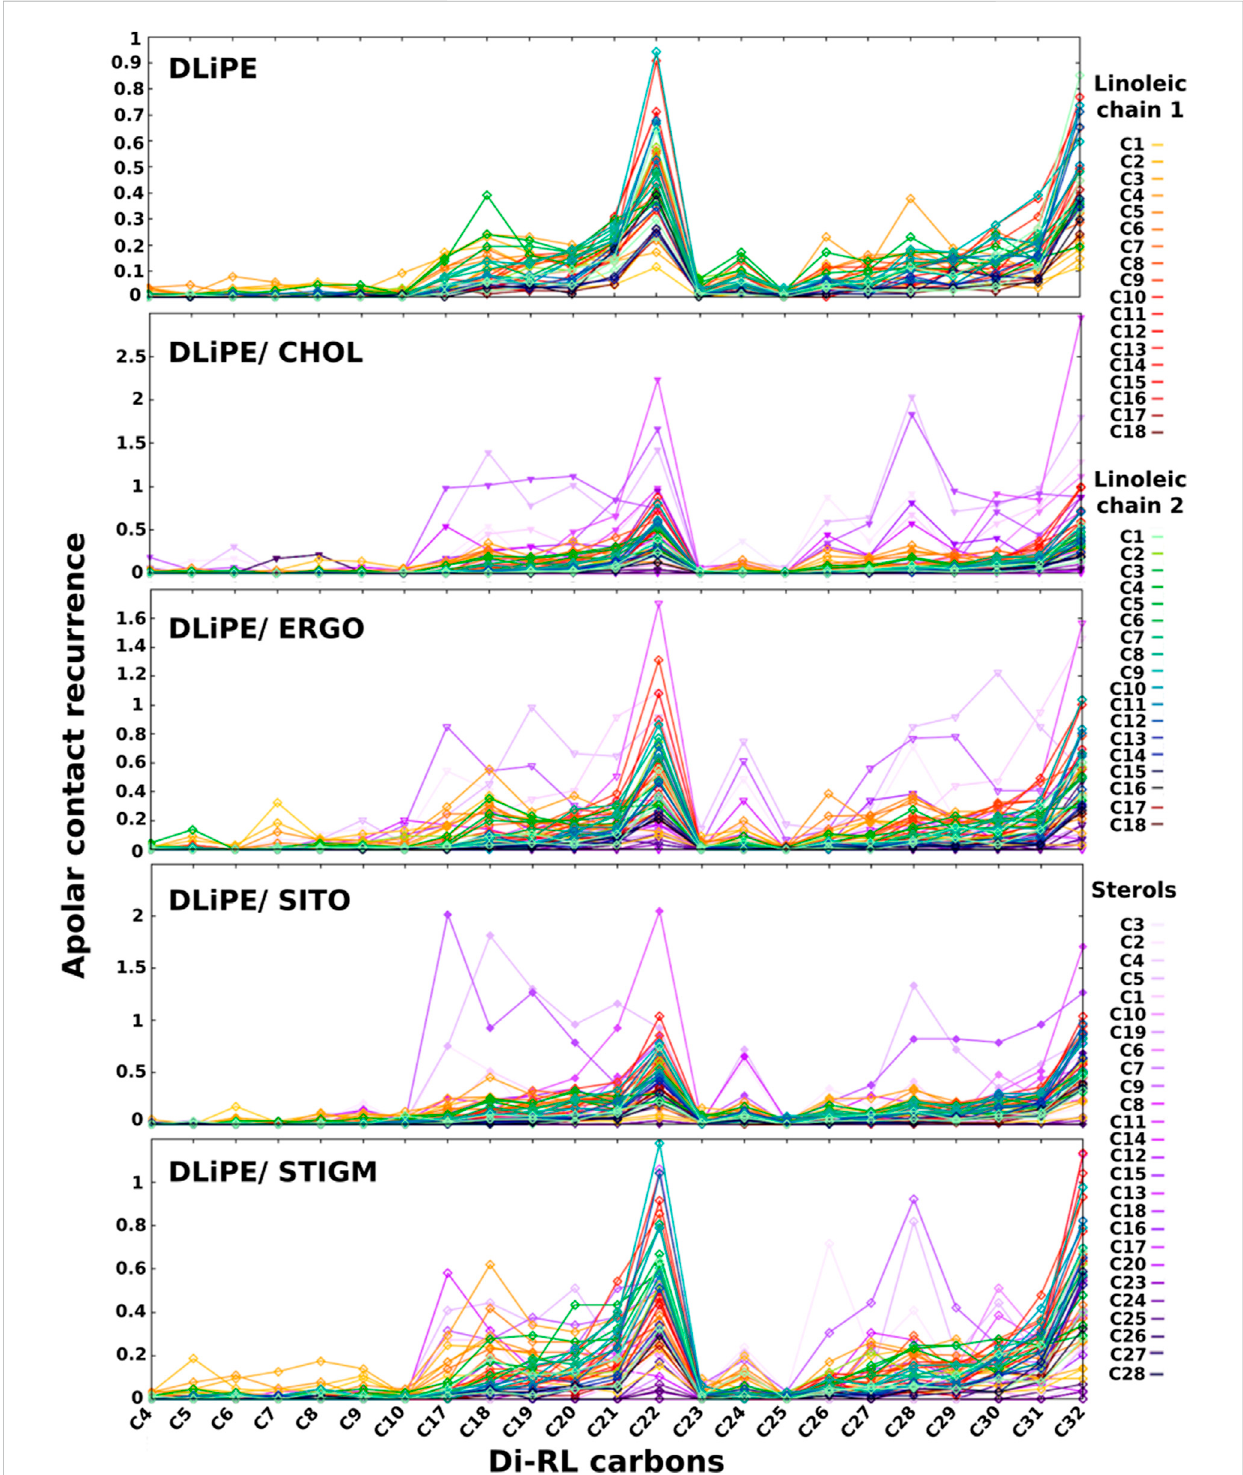
FIGURE 7 Recurrenceofclosecontactsbetweenapolaratomsofdi-RLsandthoseofphospholipids,indicatingtheformationofvanderWaalscontacts.DLiPE; DLiPE/CHOL;DLiPE/ERGO;DLiPE/SITO;DLiPE/STIGM(70/30 Mratios).Colourtonalityre fl ectsthedistancefromtheheadgroup.Carbonsarenumbered in order from the carbonyl group for linoleic chains. Sterols ’ carbon numbering is depicted in Supplementary Figures